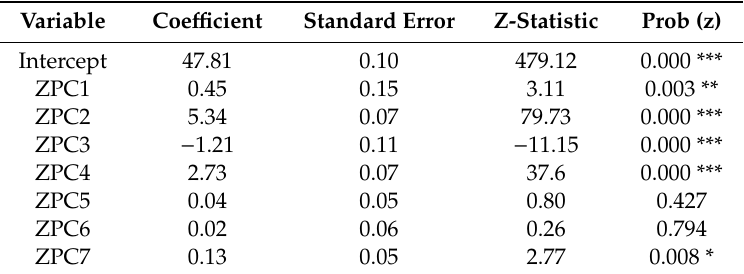
Table A2. Truncated regression